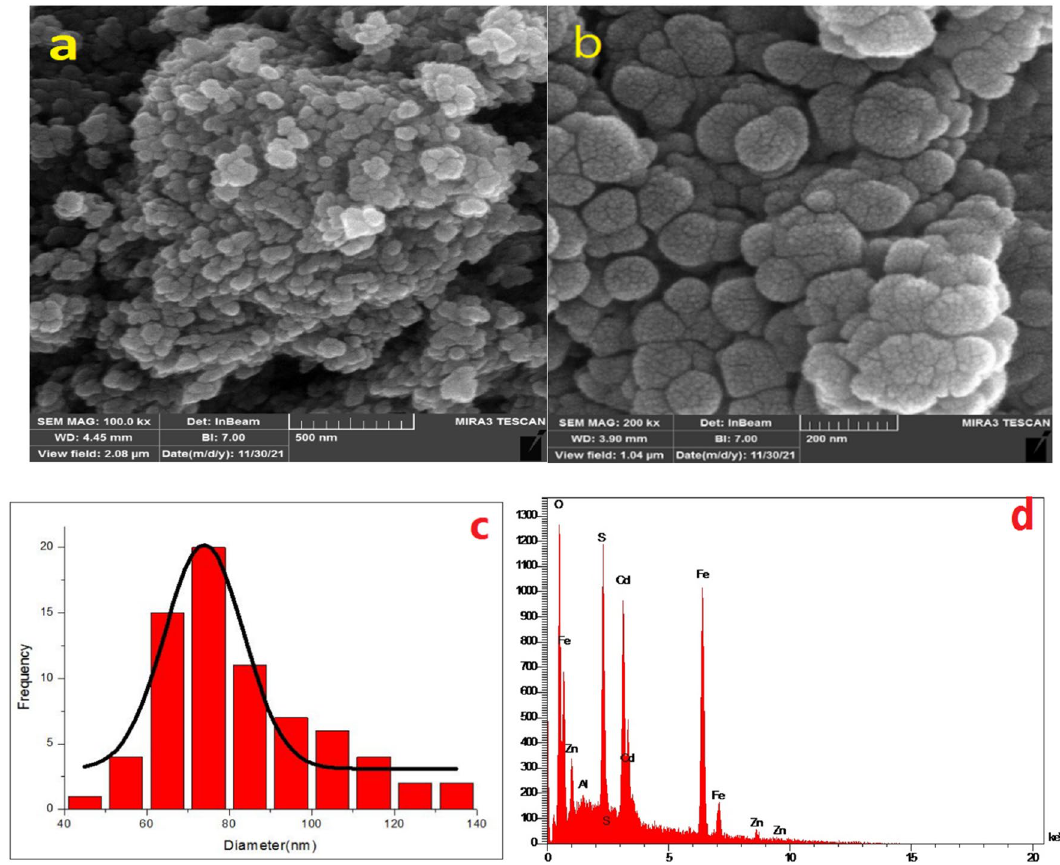
Figure 4. FESEM images of ( a ) Fe 3 O 4 @BNPs, ( b ) Fe 3 O 4 @BNPs@ZnS-CdS and ( c ) histogram size distribution of Fe 3 O 4 @BNPs@ZnS-CdS, and ( d ) EDX pattern of Fe 3 O 4